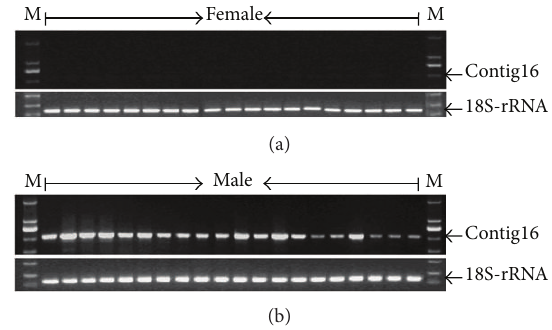
Figure 4: Expression profile of contig16 in the juvenile shrimps of female (a) and male (b) F. chinensis . M: marker (DL2000); 18S-rRNA was used to normalize the amount of cDNA of juvenile female and male shrimps.